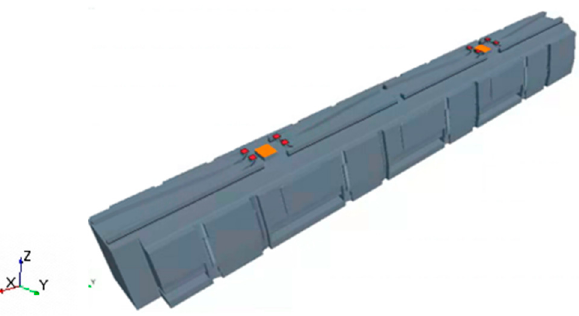
Figure 2. The integrated model of the air duct and subway train.